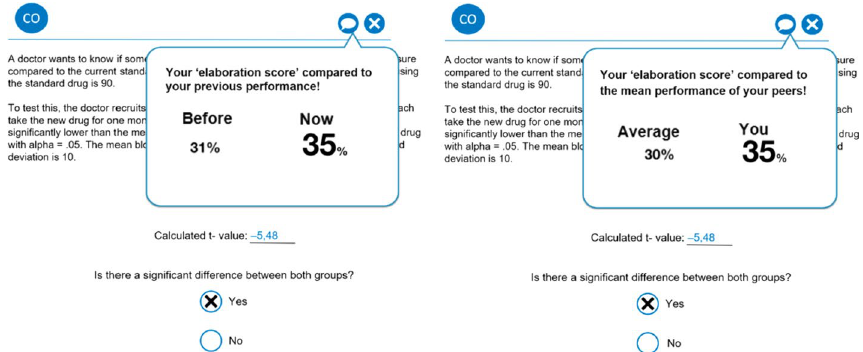
Fig. 2 Feedback types used in experiment 1. Temporal feedback on the left; social feedback on the